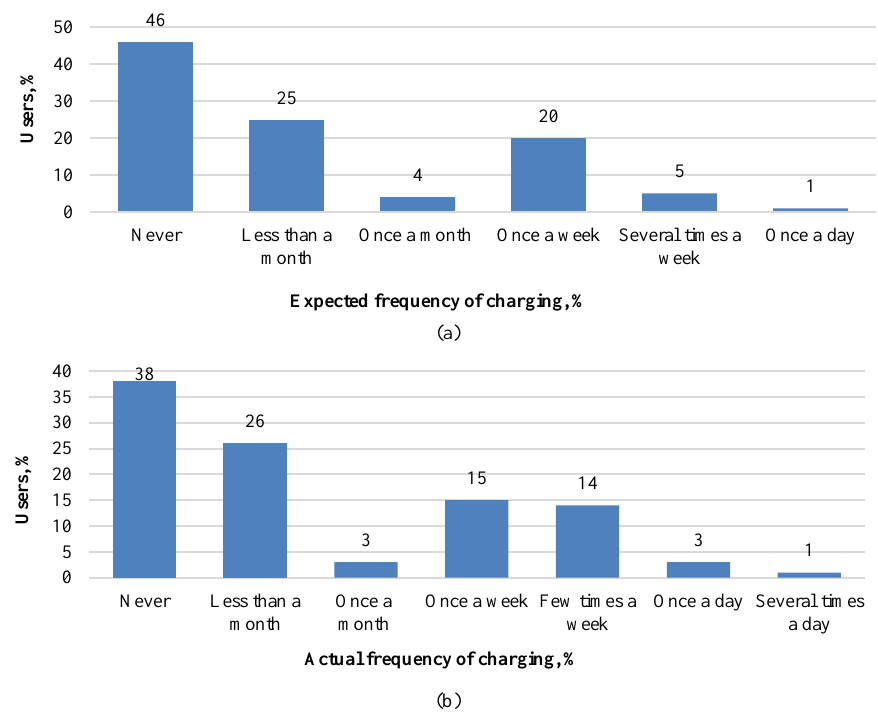
Fig. 4. (a) Survey of the EV users about their expected use of fast charging network (2016); (b) actual use of fast charging network within first 6 months of operation in